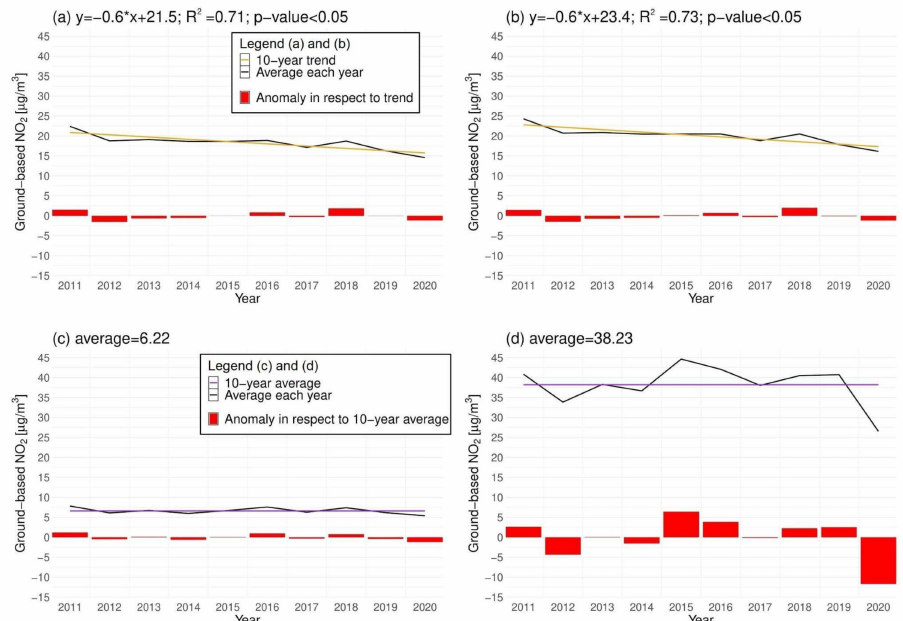
Figure 11. Mean ground-based NO 2 concentrations ( µ g/m 3 ) every year (black line: ( a – d )), trends (orange line: ( a , b )) and anomalies (red bars: ( a – d )) with respect to trends across Poland ( a ); urban areas ( b ); non-built-up areas ( c ); and Warsaw ( d ). For statistically insignificant trends, anomalies were calculated with respect to averages (purple line: ( c , d